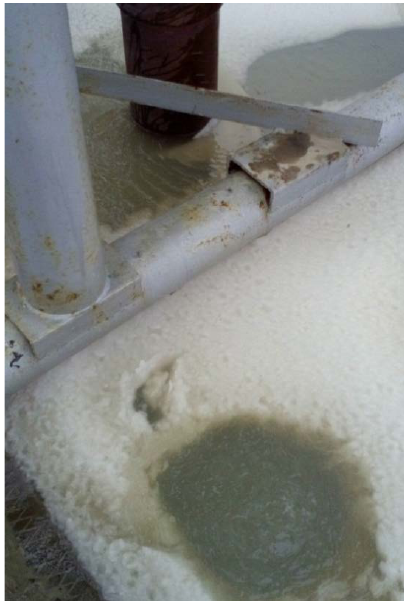
Figure 2. Distant gas release from thawed permafrost massif around working gas well at the Yamburg gas field [10].